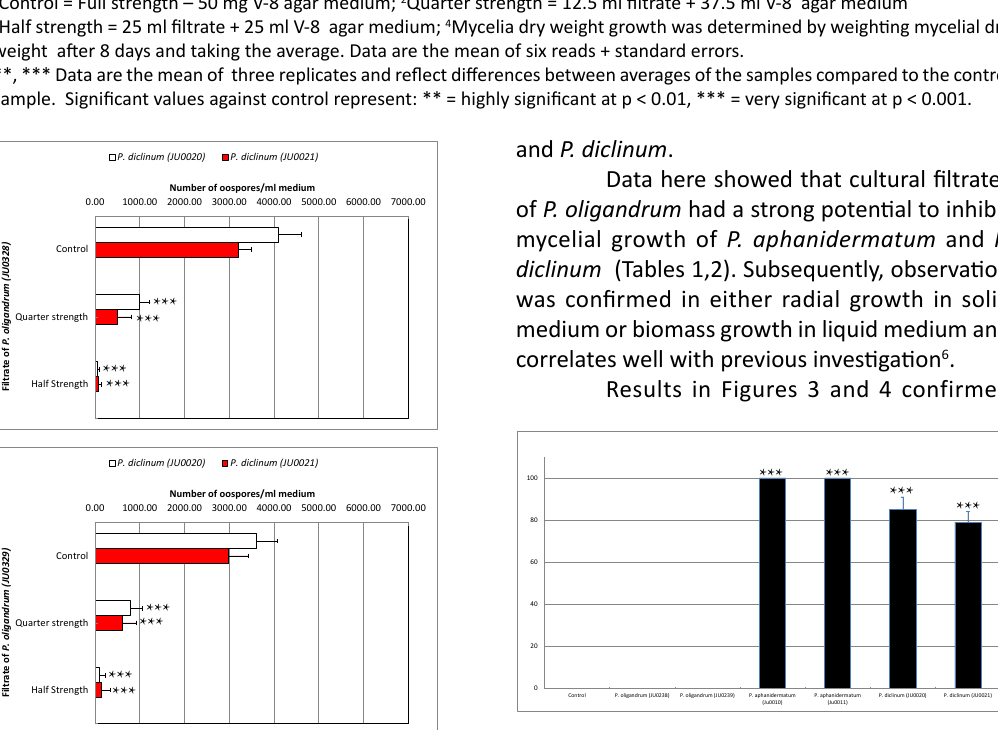
Fig. 5. Pre-emergence damping-off of cucumber germinating seeds grown in clay sand soil infested with tested each of 2 isolates of P. oligandrum , P. aphanidermatum and P. diclinum . Control is all the mixture of the inocula, but without fungal growth. Bars above all drawing column, represent the standard error of the average data from 5 pots x 20 seeds = 100 measurements and reflect differences between averages of the samples compared to the control sample. Significant values against control represent: *** = very significant at p <